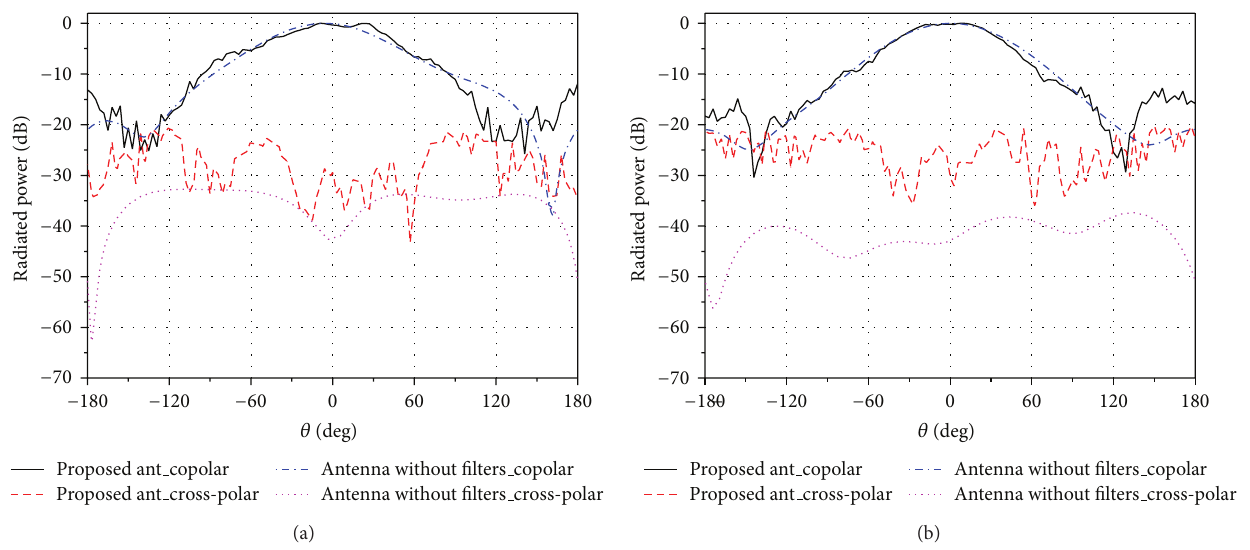
Figure 7: Measured radiation pattern for port 1 (2.1GHz). (a) E-plane ( 𝑦 - 𝑧 plane), (b) H-plane ( 𝑥 - 𝑧 plane).